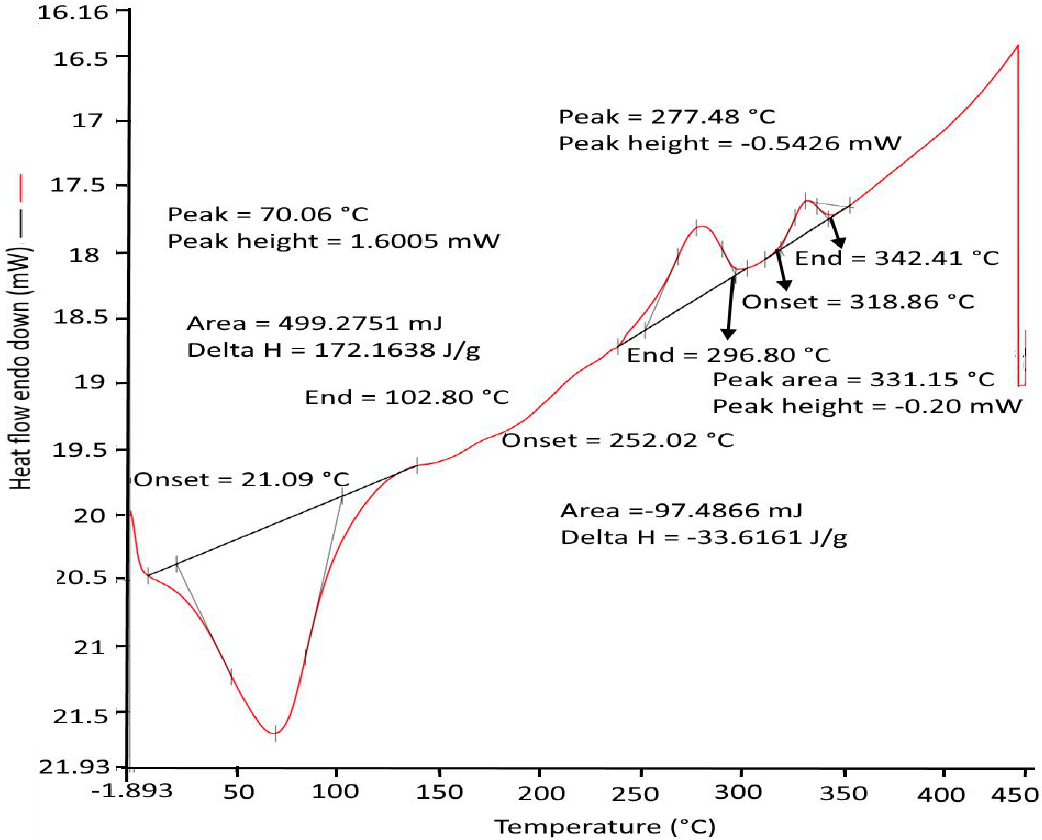
Figure 2. DSC thermograph of corn silk powder. The red line represent the Heat flow and the black line represents the area demarcation for each peak.